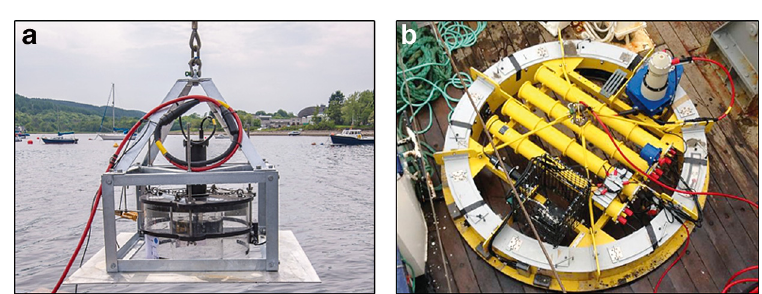
Fig. 2. Benthic flumes used in the study. (a) Voyager I mini-flume; (b) plan view of the Voyager II benthic